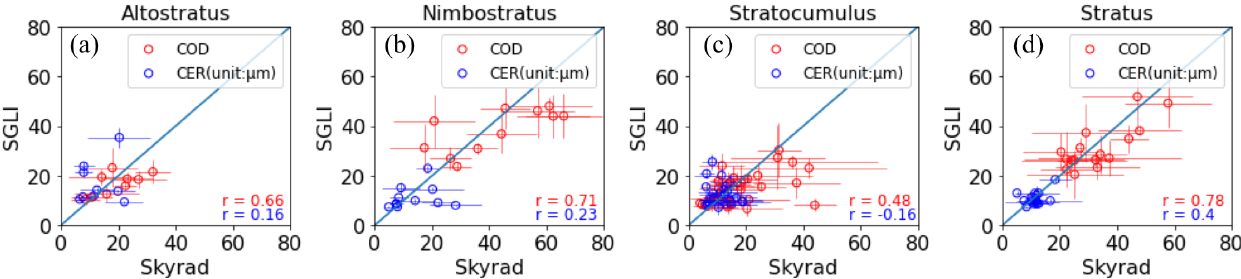
Figure 5. Comparison between the sky radiometer-observed and SGLI-observed water cloud properties for different types of clouds. The cloud type corresponds to the central pixel of the 5 × 5 SGLI pixels.